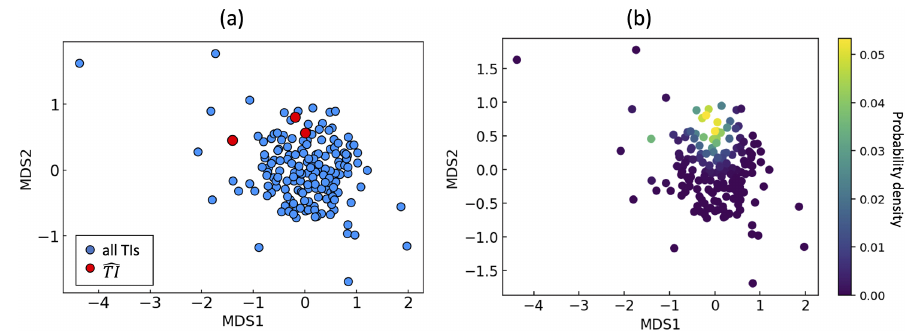
Figure 9. (a) Estimated (cid:98) TI for subarea A1 in MDS space. The red dots are the (cid:98) TI, while blue points represent other TIs. (b) Kernel density smoothing assigns likelihoods (densities) to the total set of training images by using (cid:98)